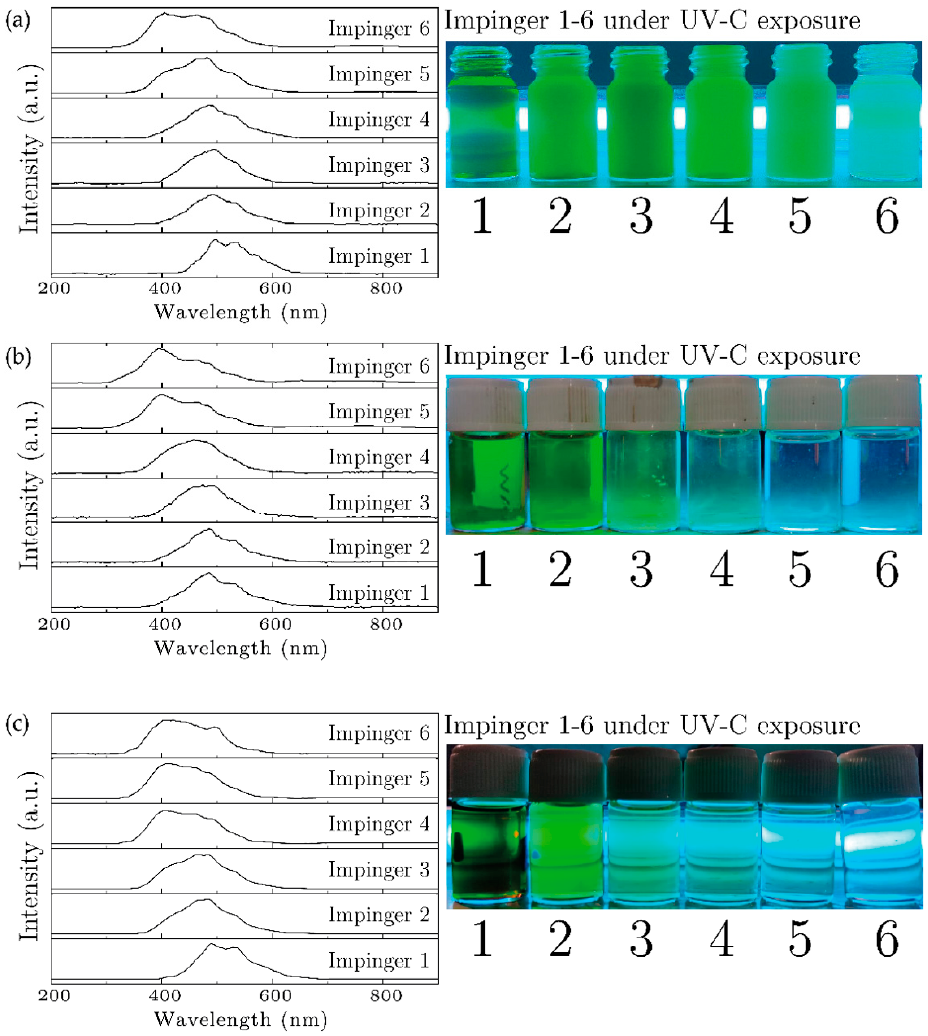
Figure 5. The effect of different plasma powers: 0 Watts ( a ), 42 Watts ( b ), 85 Watts ( c ) on the emission spectrum of tar in impinger 1–6.